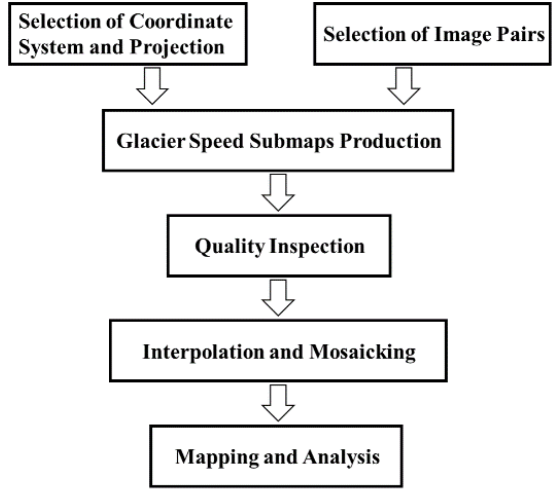
Figure 1. Framework of ice flow velocity mapping based on historical optical images